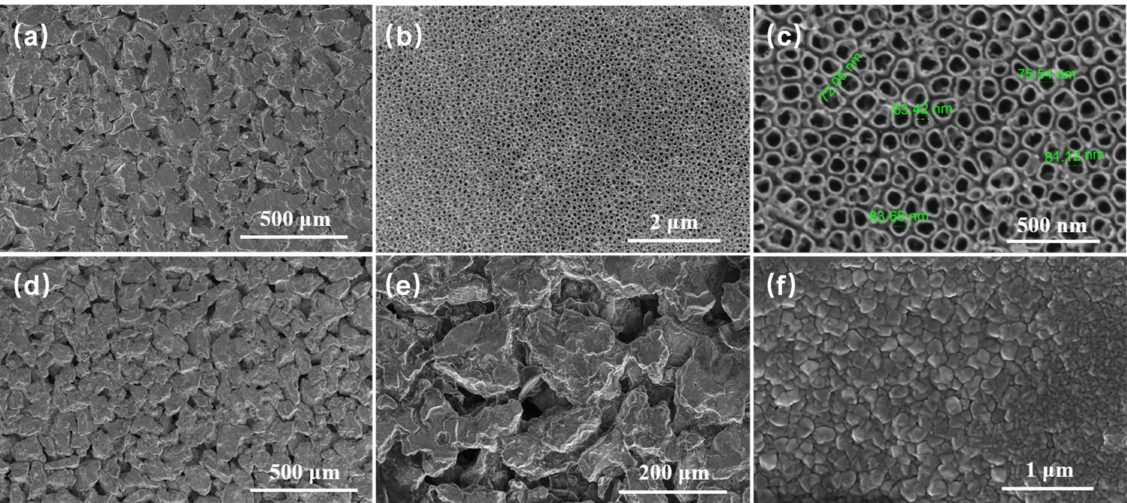
Figure 2. FESEM images of porous Ti substrate and PbO 2 -REM: ( a ) porous Ti substrate ( × 400), ( b ) TiO 2 NTAs ( × 50,000), ( c ) TiO 2 NTAs ( × 200,000), ( d ) PbO 2 layer ( × 400), ( e ) PbO 2 layer ( × 600), and ( f ) PbO 2 layer ( × 100,000).